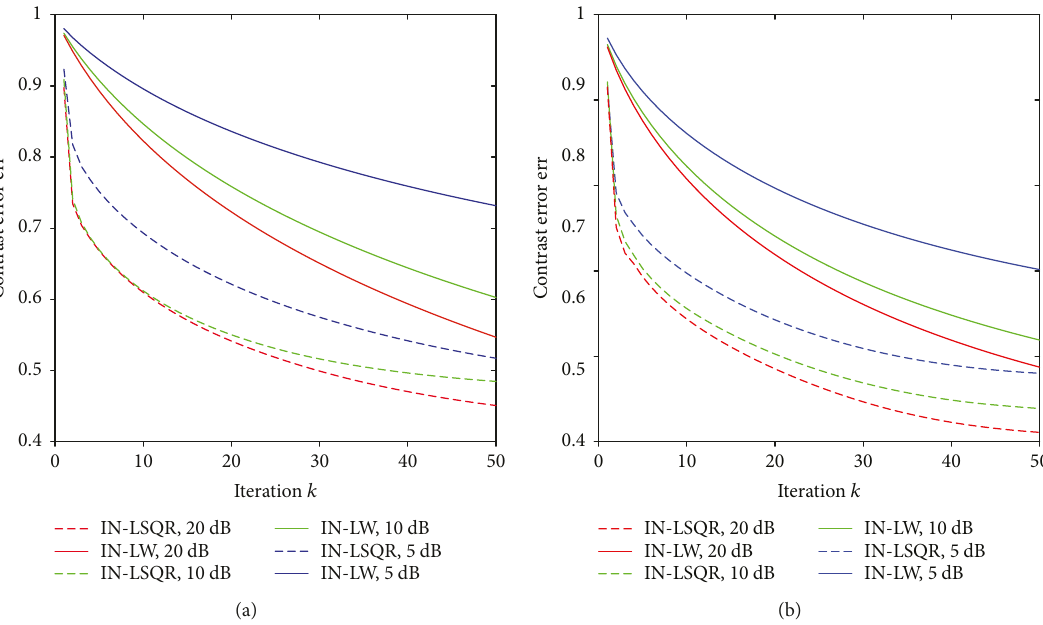
ff erent noise levels in dielTM; k computed by IN-LSQR and IN-LW for di